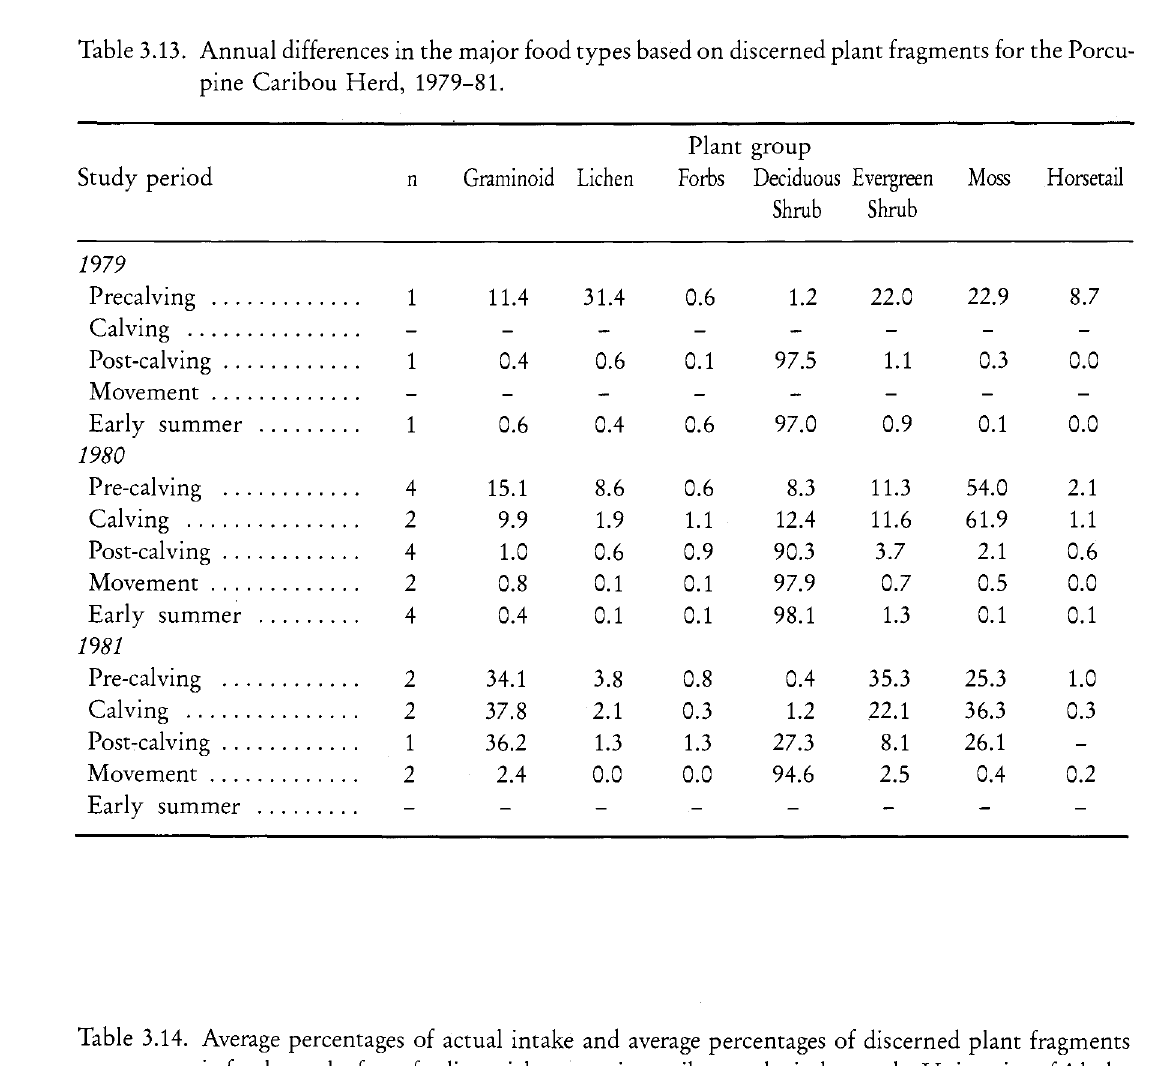
Table 3.14. Average percentages of actual intake and average percentages of discerned plant fragments in fecal samples from feeding trials on captive caribou and reindeer at the University of Alaska in 1982 by L.